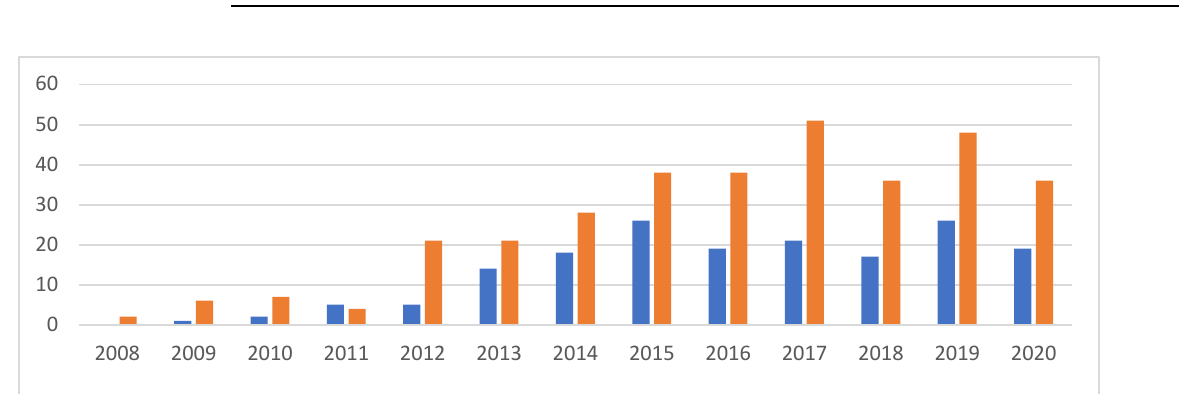
Figure 1. Numbers of publications with and without international collaboration from 2008 to 2020.